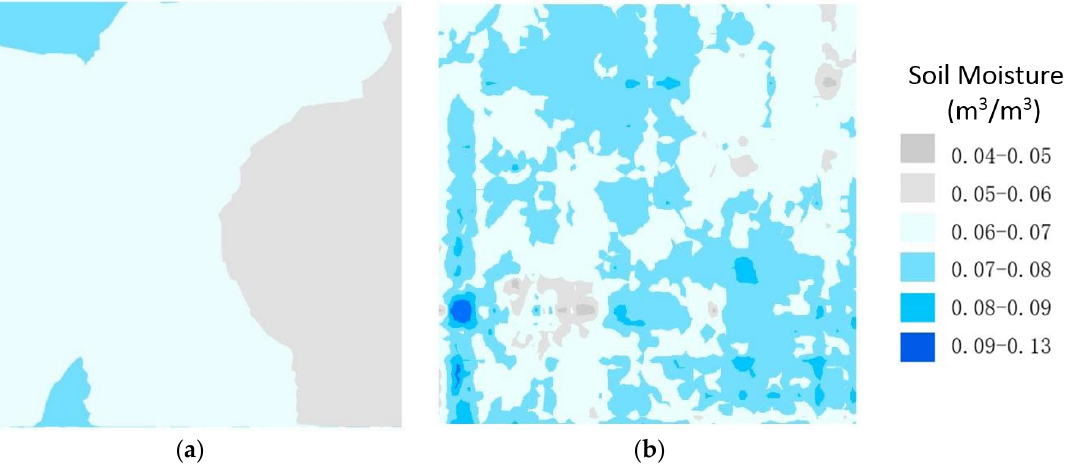
Figure 8. Spatial distributions of soil moisture in Plot C by sampling method based on gravimetric data, and pixel-scale measurement method based on GPR.